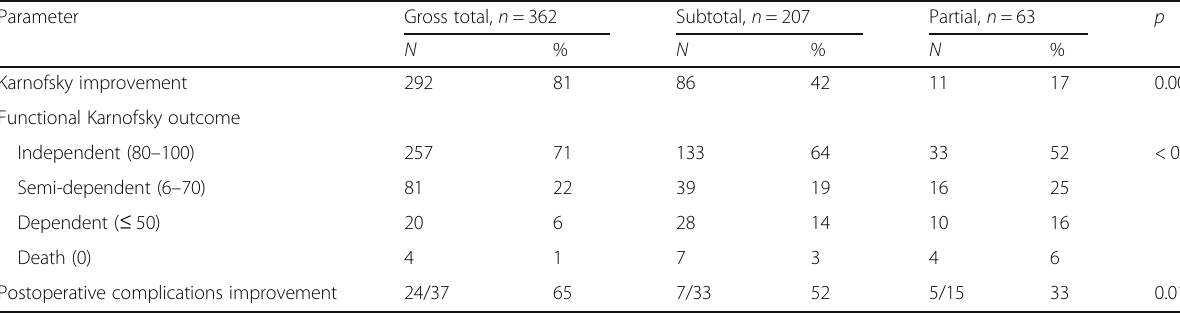
Table 5 Patients ’ outcome at postoperative third month regarding the extent of resection Parameter Gross total, n = 362 Subtotal, n = 207 Partial, n = 63 p N % N % N % Karnofsky